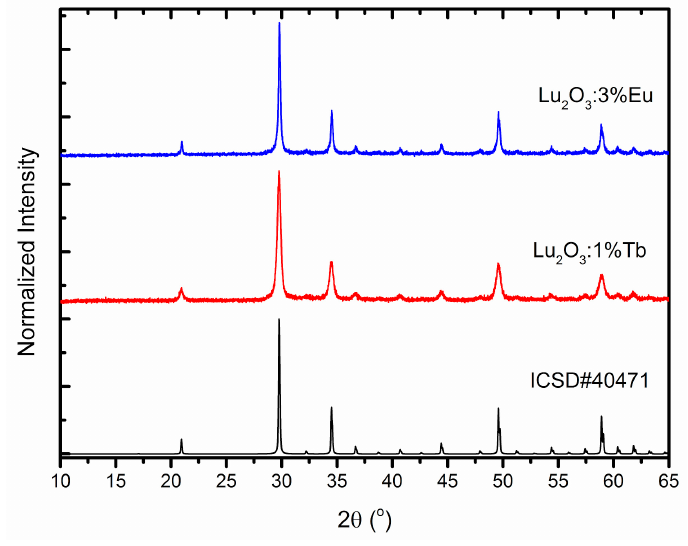
Figure 1. XRD patterns of the Lu 2 O 3 :Eu and Lu 2 O 3 :Tb powders and the simulated one for cubic Lu 2 O 3 [3].